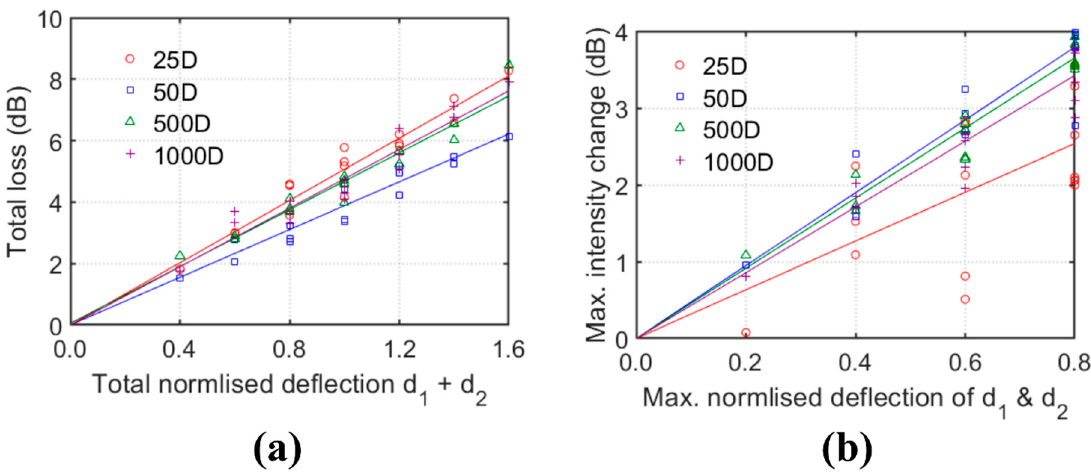
Figure 11. Relationships of ( a ) total loss vs. total normalised deflection and ( b ) maximum intensity change vs maximum normalised deflection.